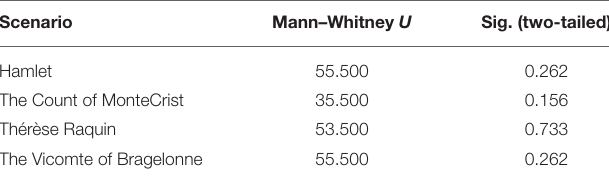
TABLE 9 | Audience studio: simple matching coefficients (moral emotion set).